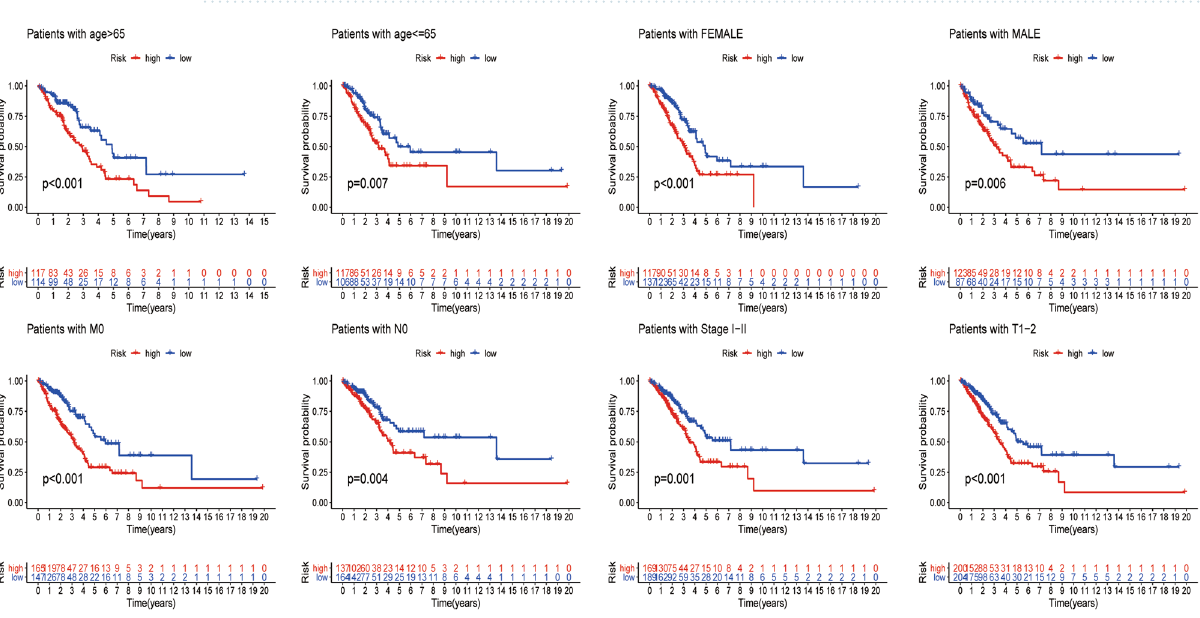
Figure 6. Kaplan–Meier curves of differences in overall survival stratified by sex, age, or TNM stage between the low-risk and high-risk groups in the entire TCGA